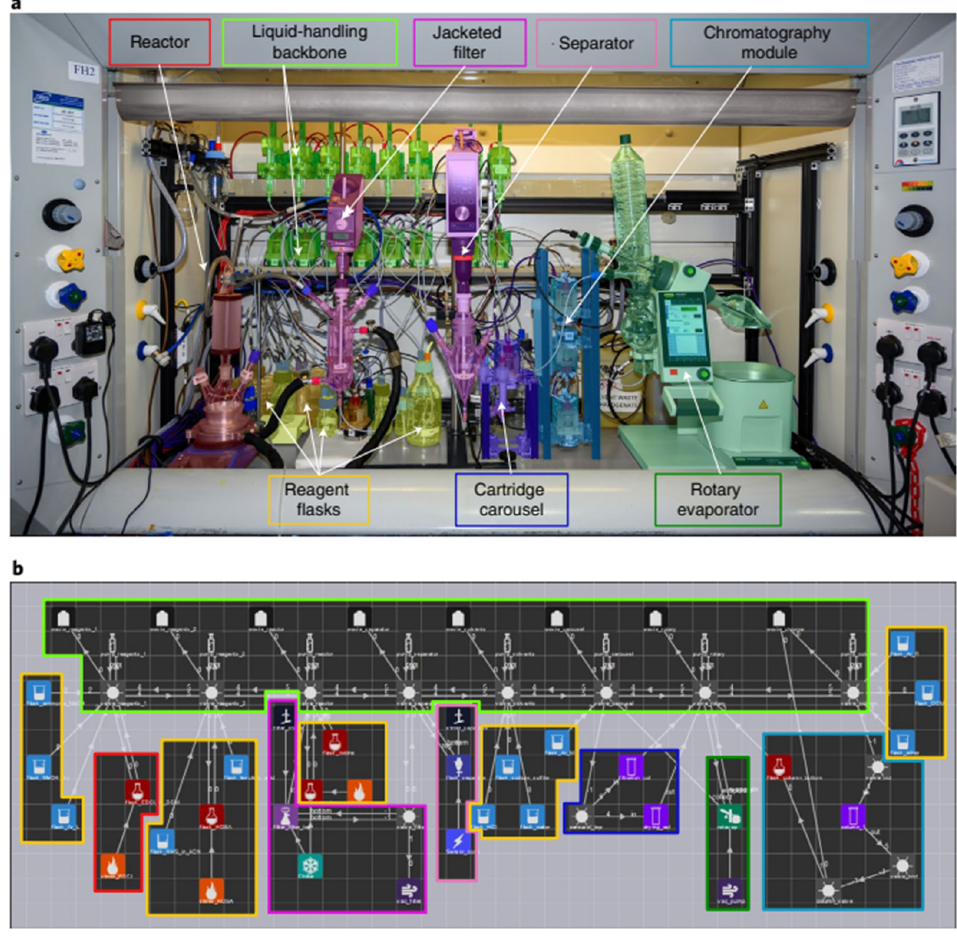
Figure 8. Implementation and structure of the automated synthesis platform: ( a ) hardware module for synthesizing the NHS ‐ diazirine; ( b ) diagram of the corresponding software. Reprinted with permission from ref. [56]. Copyright 2020, Springer Nature Liminted.